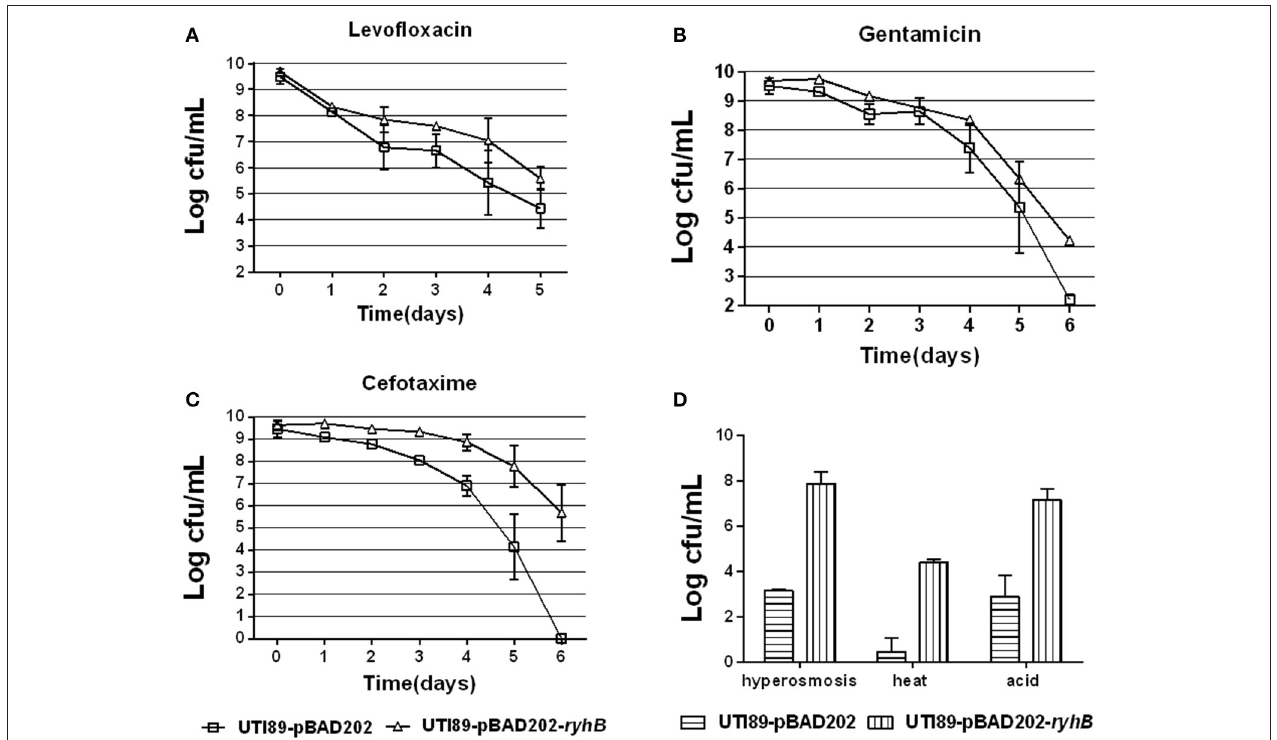
FIGURE 3 | Overexpression of RyhB confers higher persistence levels. (A–C) Susceptibilities to antibiotics levofloxacin (5 µ g/mL, A ), gentamicin (30 µ g/mL, B ) or cefotaxime (128 µ g/mL, C ) at the time points indicated. (D) Susceptibilities to stresses hyperosmosis (NaCl, 4M), heat (55 ◦ C) or acid for 3 d, 3 or 12h, respectively. Bacteria were cultured to the stationary phase ( ∼ 10 9 CFU/mL) prior to the addition of antibiotics or stresses. Error bars show standard variations in CFU between at least three independent experiments.